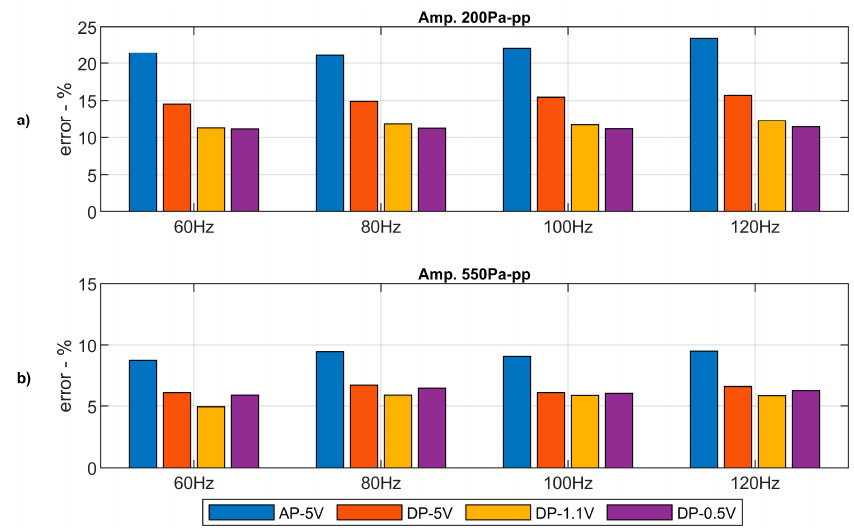
Figure 10. Relative amplitude error for the different sensors’ arrangements at different frequencies of the sound wave. ( a ): Lower amplitude signals. ( b ) Higher amplitude signals.